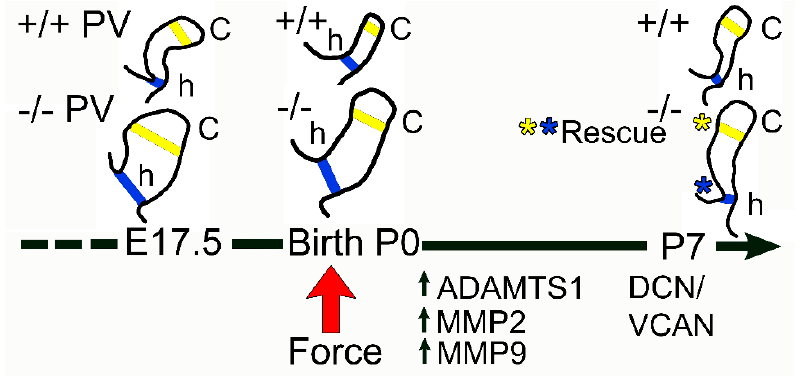
Figure 7. Schematic depicting the transient morphological rescue of the pulmonary valve in Adamts5 − / − mice after birth. Timeline of late prenatal and early postnatal phenotype of the pulmonary valve (PV), at embryonic day 17.5 (E17.5), birth (P0), and postnatal day 7 (P7). The schematic shows the left cusp of the PV drawn to relative scale within timepoints to compare the Adamts5 +/+ (+/+; wild type, WT) and Adamts5 − / − ( − / − ) PVs. Yellow lines indicate width measurements of the cusps while blue lines indicate the width measurements of the hinge regions. At P7, Both the cusp and the hinge regions are reduced in the − / − cusps and similar to +/+ (asterisks yellow and blue, respectively). Red arrow indicates birth with onset of blood flow to the lungs. ADAMTS1, MMP2, and MMP9 exhibited expanded localization profiles in the − / − PV after birth. The rescued Adamts5 − / − PV also exhibited complementary localization of DCN and VCAN which had overlapping expression at E17.5 and birth.